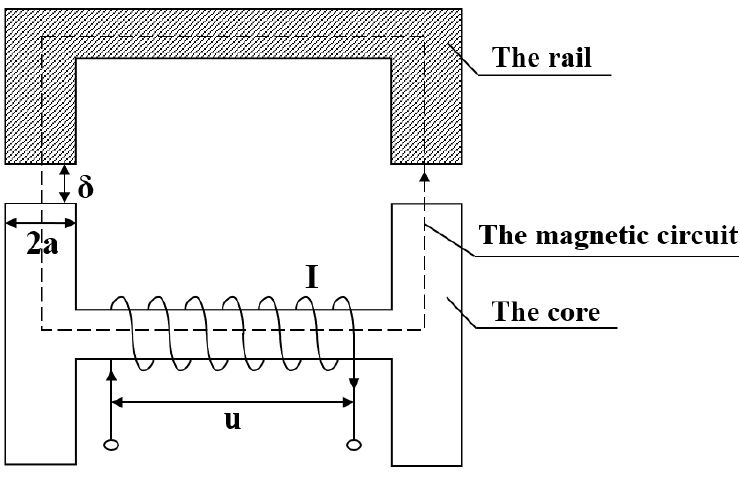
Figure 2. Two dimensional schematic diagram of the single suspension magnet